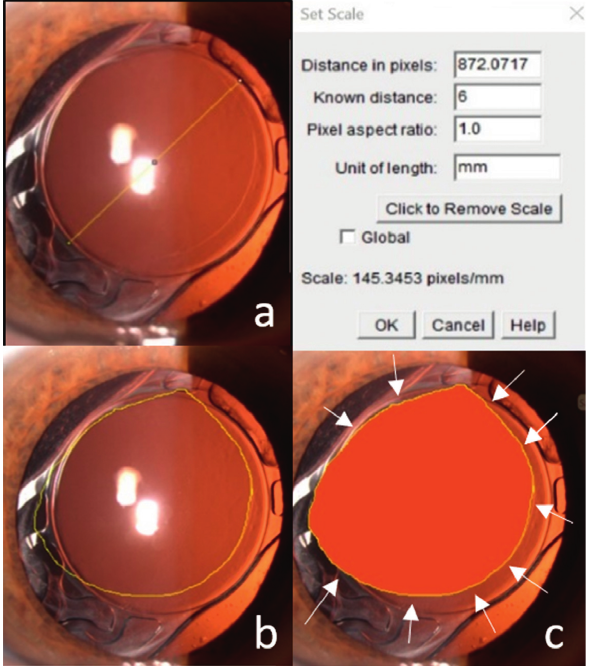
Figure 1: Anterior capsule opening analysis with ImageJ software. (a) Setting of the scale measuring the 6 mm IOL optic plate di- ameter as known true size. (b) Laying out of the contour of anterior capsule edge. (c) Software analysis (capsulotomy area indicated in